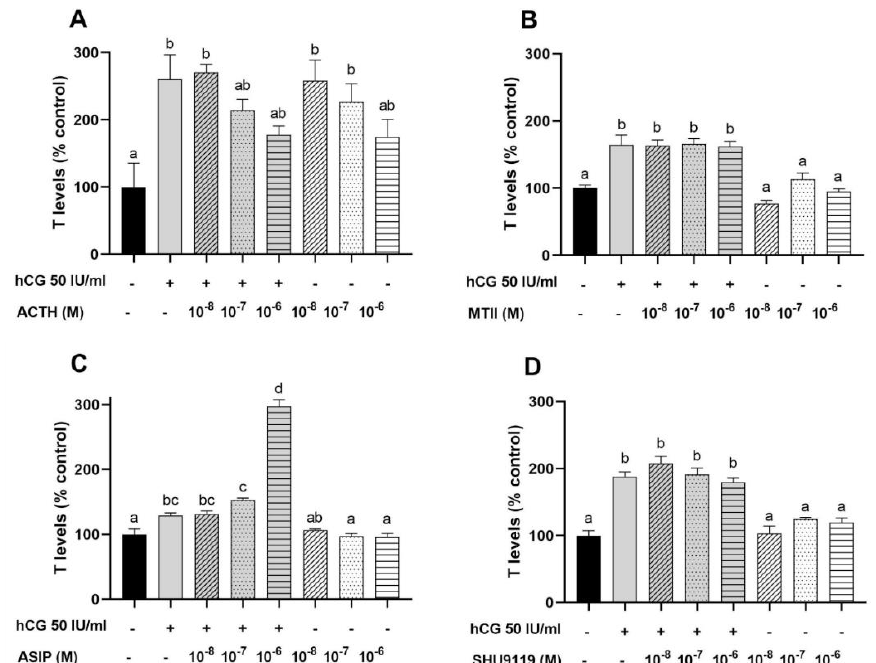
Figure 5. Effect of melanocortin peptides on basal and human chorionic gonadotropin (hCG)-induced testosterone (T) in primary cell cultures of dispersed testicular cells of zebrafish. ( A ) Effects of ACTH, ( B ) MSH chemical analogues (MTII), ( C ) human ASIP and ( D ) chemical antagonist (SHU9119). Experiments were performed in triplicate and repeated at least three times. Data is expressed as a percentage of the control (mean ± SEM). Different letters indicate significant variations after a one-way ANOVA analysis, followed by Tukey’s post-hoc test, p <